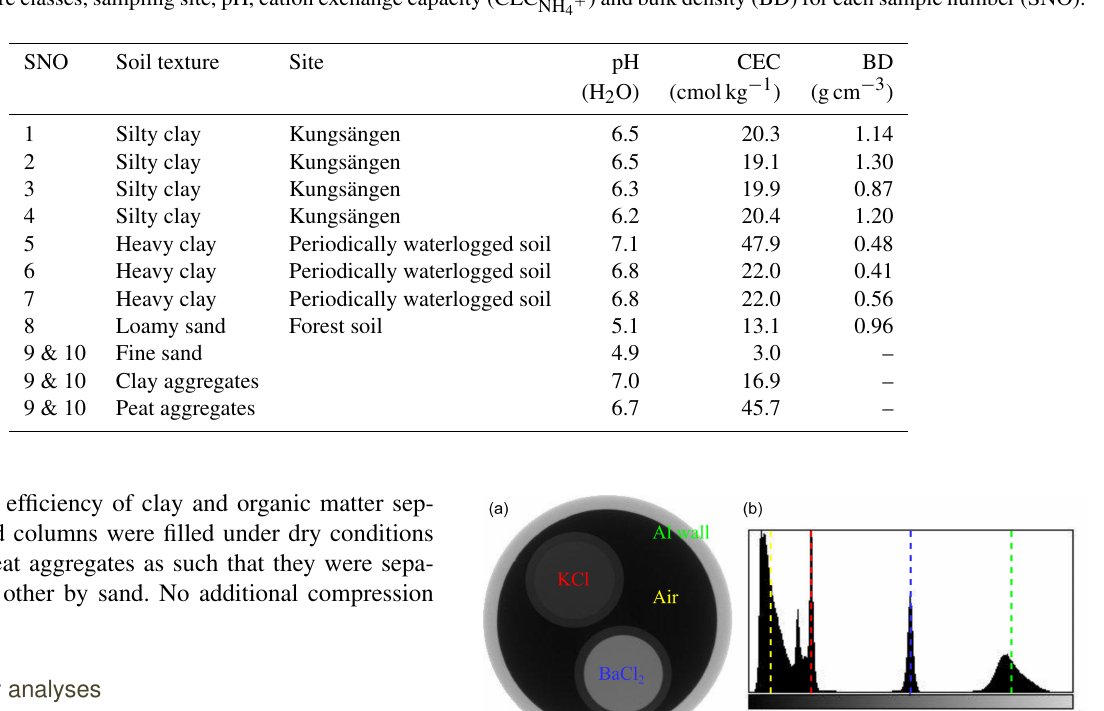
+ ) and bulk density (BD) for each sample number (SNO). 4